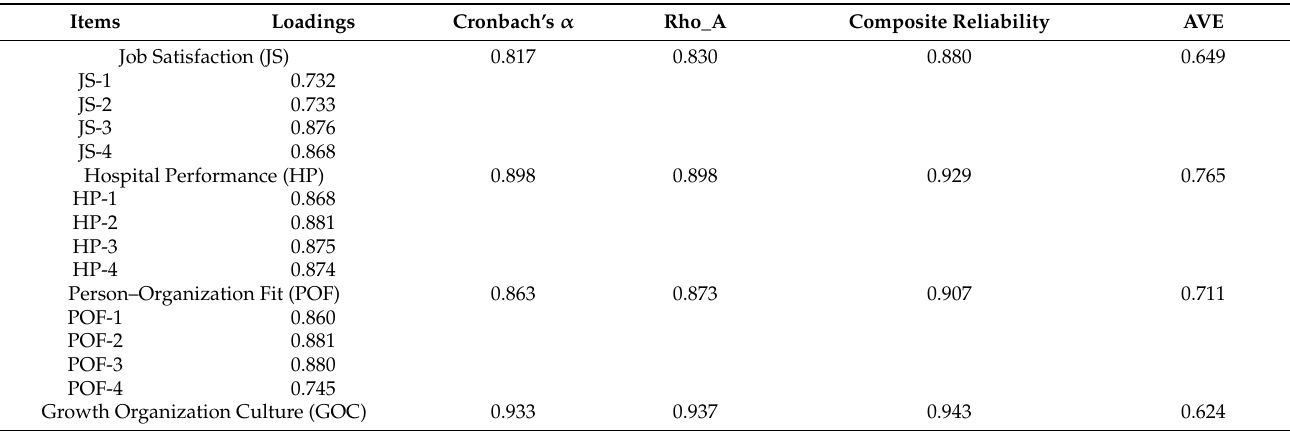
Table 2. Measurement model